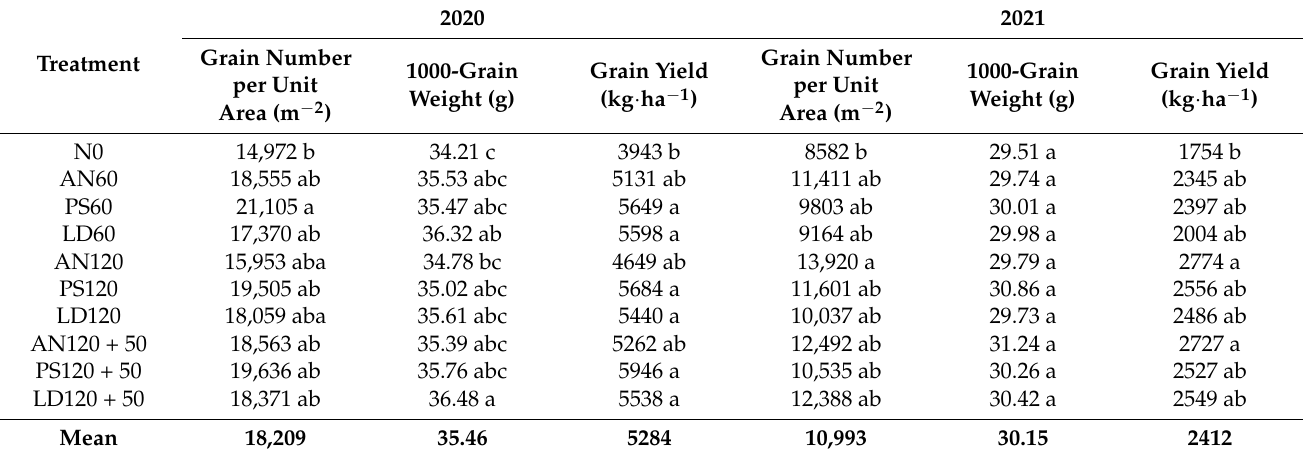
Table 6. Harvest components and grain yield of waxy winter